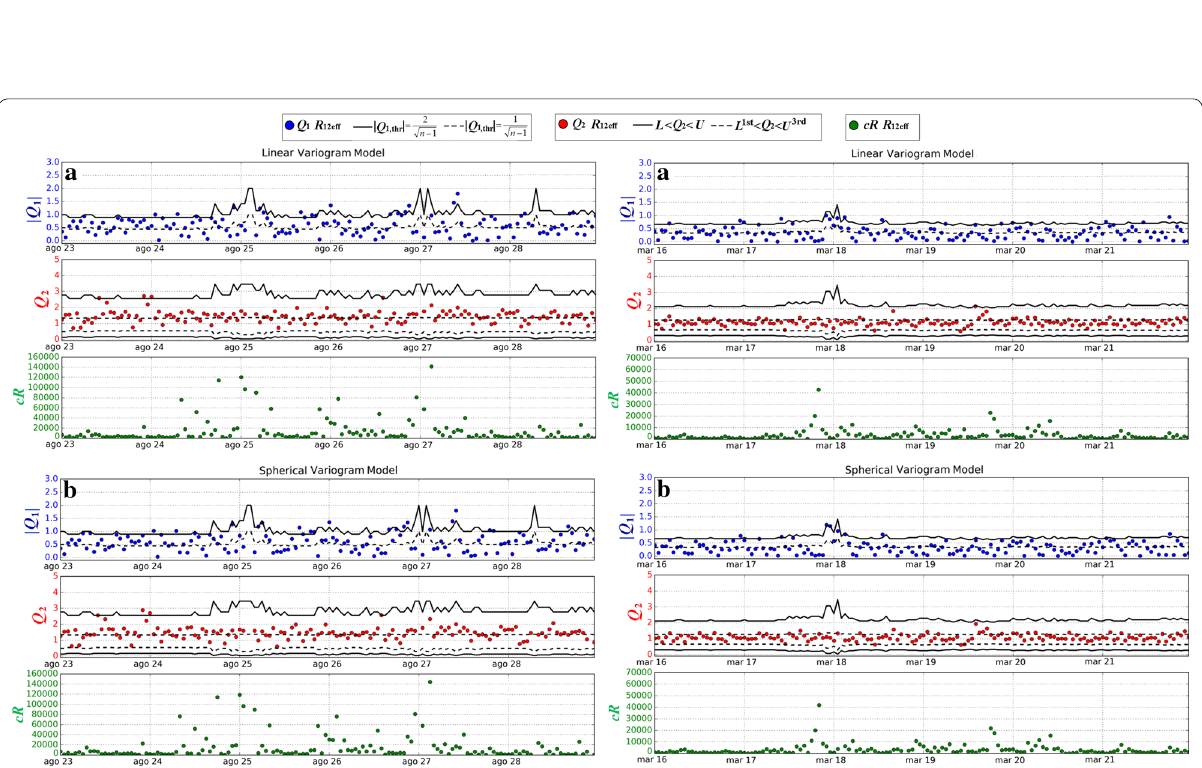
Fig. 9 Q 1 , Q 2 , and cR time series for R 12eff , for selected storms and variogram models. Same as Fig. 8, but for R